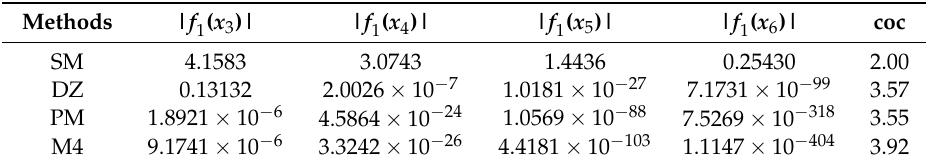
Table 1. Result of comparisons for the function f 1 .